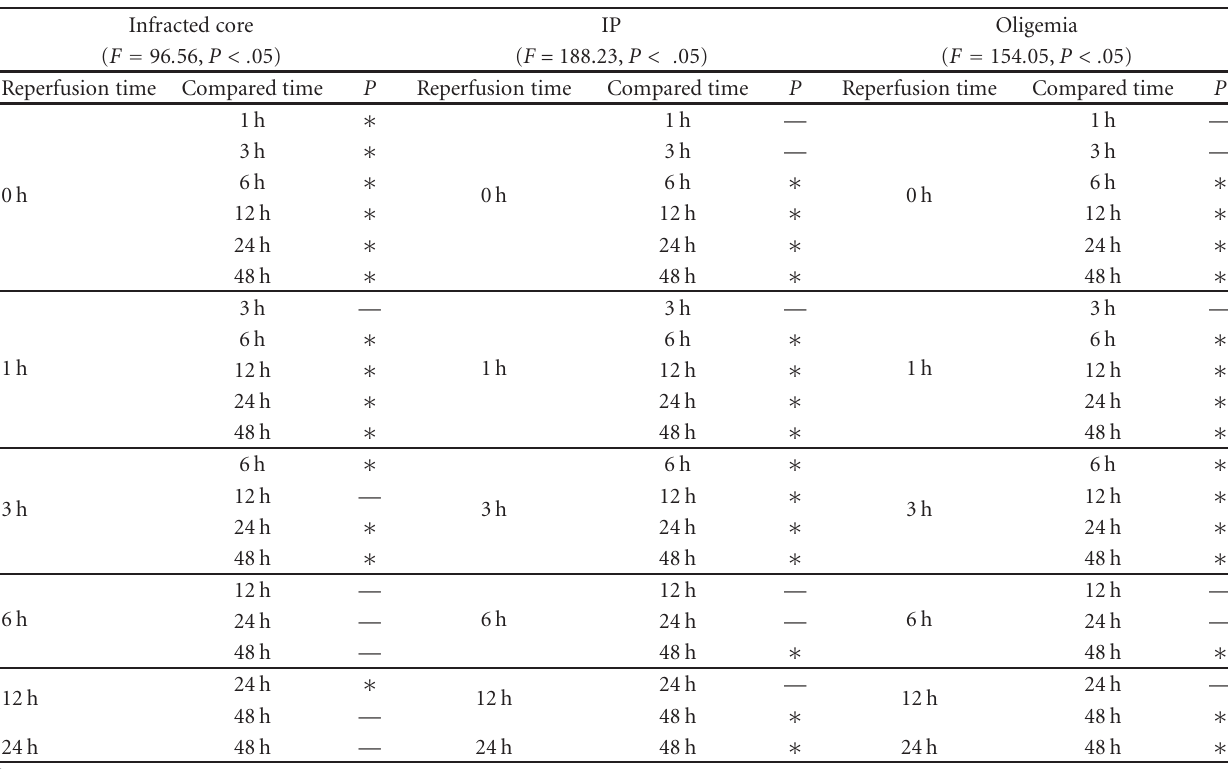
Table 3: Time evolution of rR2 (cid:2) in infarcted core, IP, and oligemia after reperfusion (compared by ANOVA).